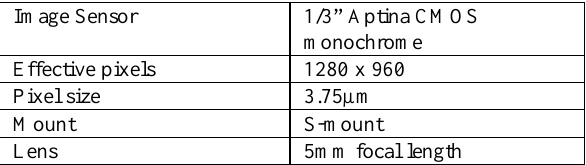
Features of the USB industrial camera